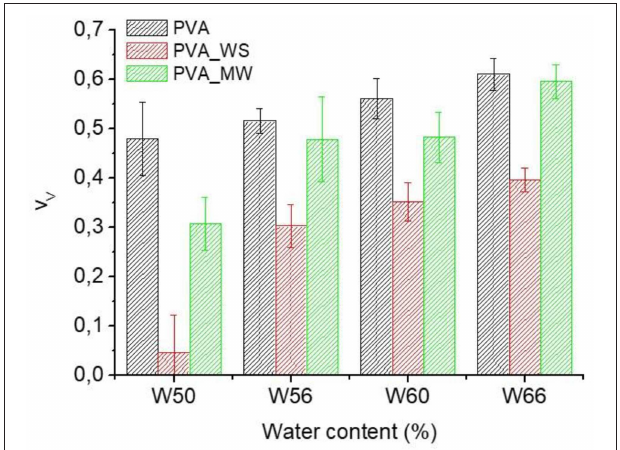
FIGURE 2 | Rheological analyses on neat PVA and PVA mixed with walnut shells and municipal solid waste.